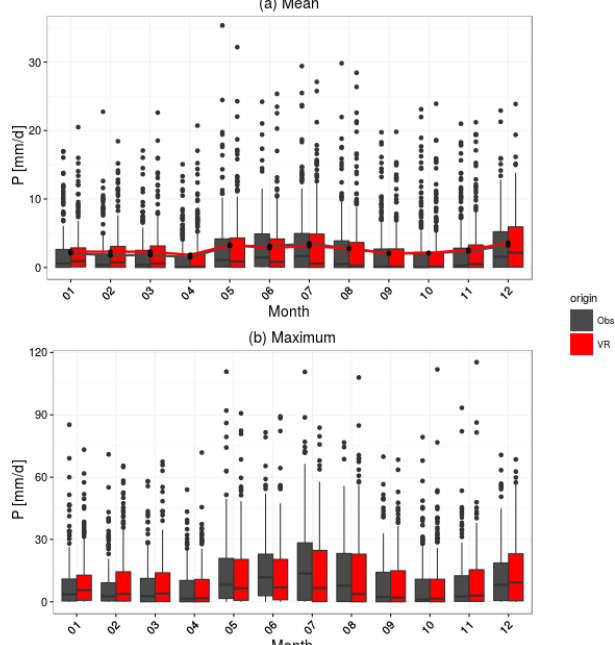
Figure 5. Mean diurnal precipitation cycle for the 71 DWD sta- tions and the corresponding simulations for wet days (more than 1mmd − 1 ) for June–August (a) and December–February (b) sea- sons. The upper and lower hinges correspond to the first and third quartiles, the center black line indicates the median, the upper whisker (analog for lower whisker) extends from the hinge to the highest value within 1.5 · (interquartile range), and the black dots mark the outliers.